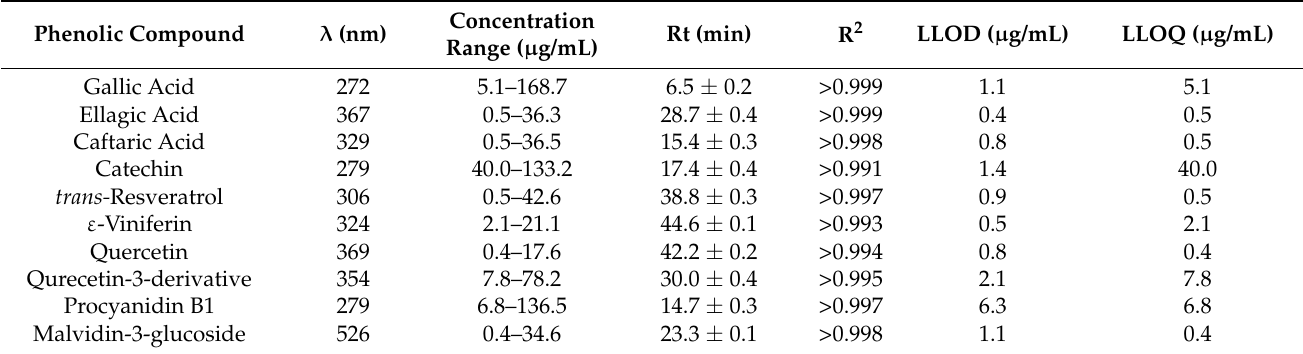
Table 1. Calibration parameters for each individual phenolic